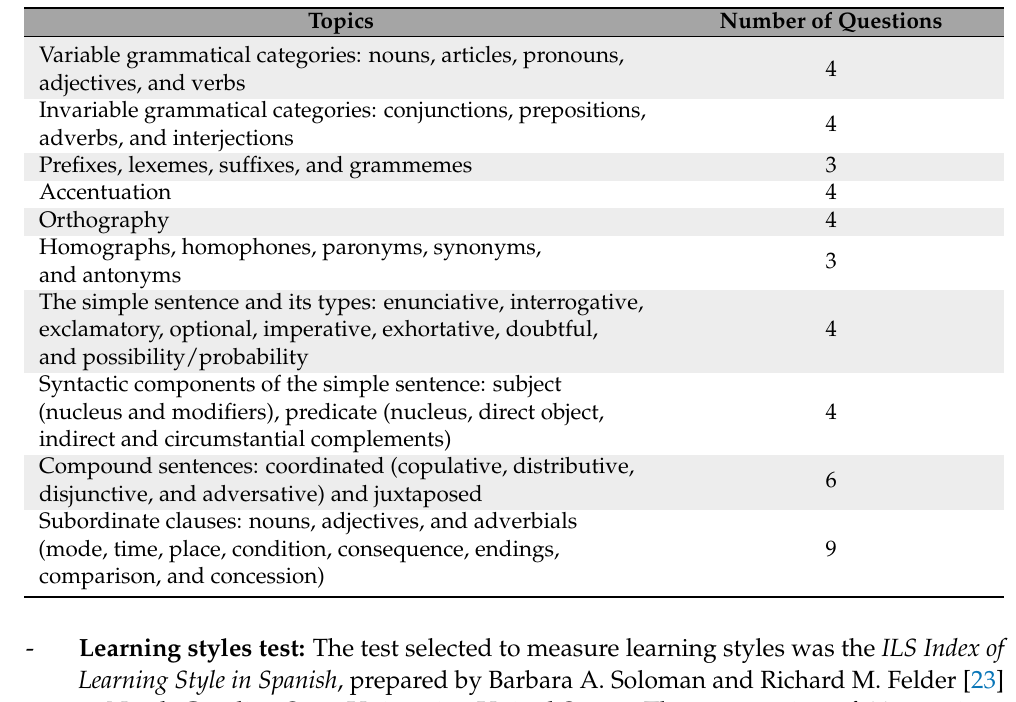
Table 4. Contents of the standardized